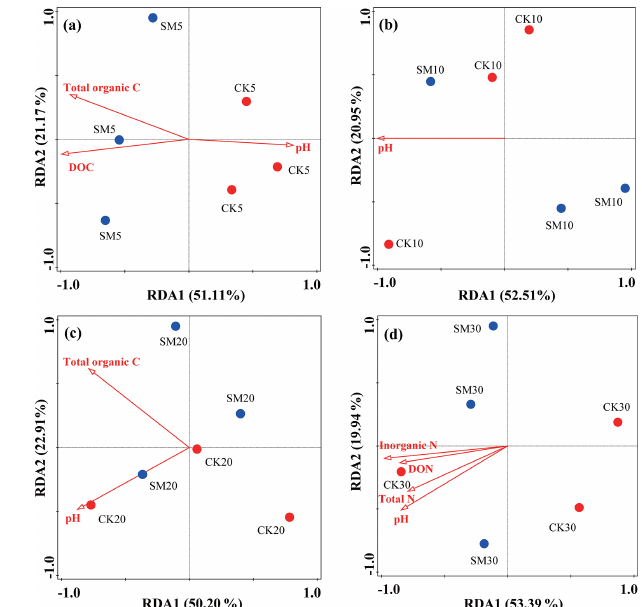
Figure 3. Redundancy analysis (RDA) of soil bacterial community changes at the OTU level and soil physicochemical property differ- ences between CK and SM plots at 0–5cm (a) , 5–10cm (b) , 10– 20cm (c) , and 20–30cm (d). CK5, CK10, CK20, and CK30 repre- sent soil sampled at 0–5, 5–10, 10–20, and 20–30cm, respectively, from the straw removal group. SM5, SM10, SM20, and SM30 rep- resent soil sampled at 0–5, 5–10, 10–20, and 20–30cm, respec- tively, from the straw mulching group. DOC, dissolved organic car- bon; DON, dissolved organic